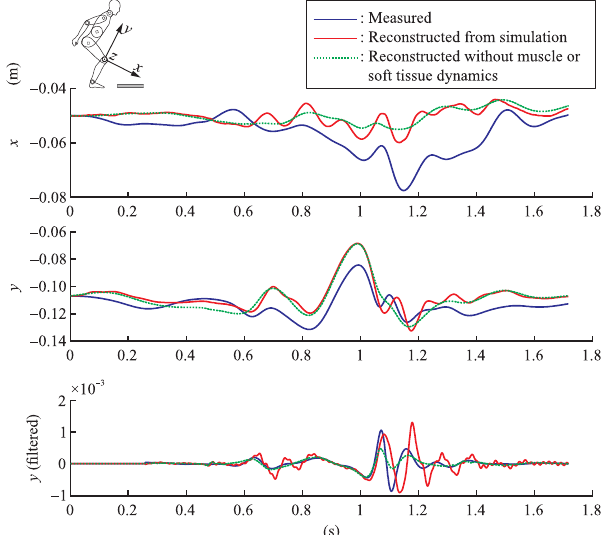
Fig. 7 Trajectories of the measured and simulated markers during the jumping motion. Each trajectory is represented in the local coordinate system fixed to the lower leg bone. The graphs only show four selected markers for clarity, but all other markers show similar trajectories. The three axes are defined as shown in the